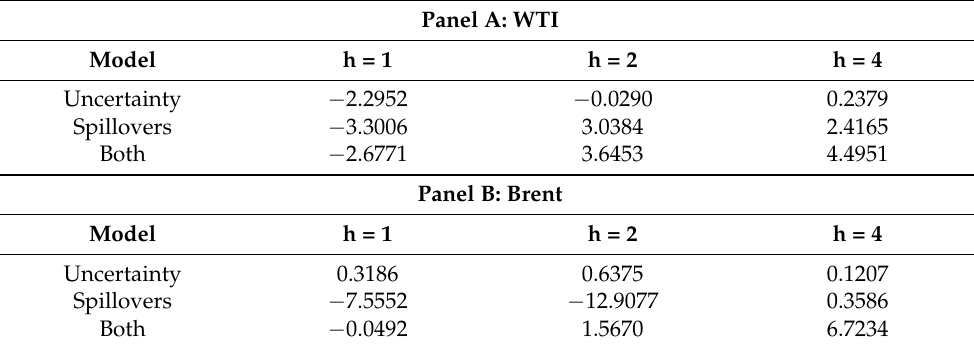
Table 2. Forecasting